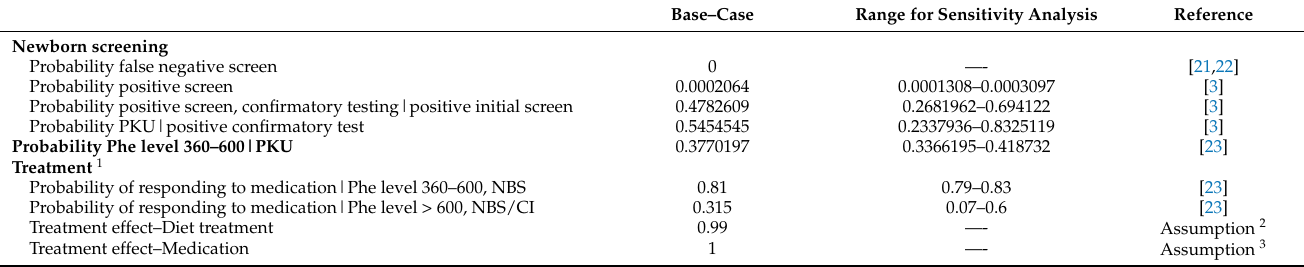
Table 1. Epidemiology